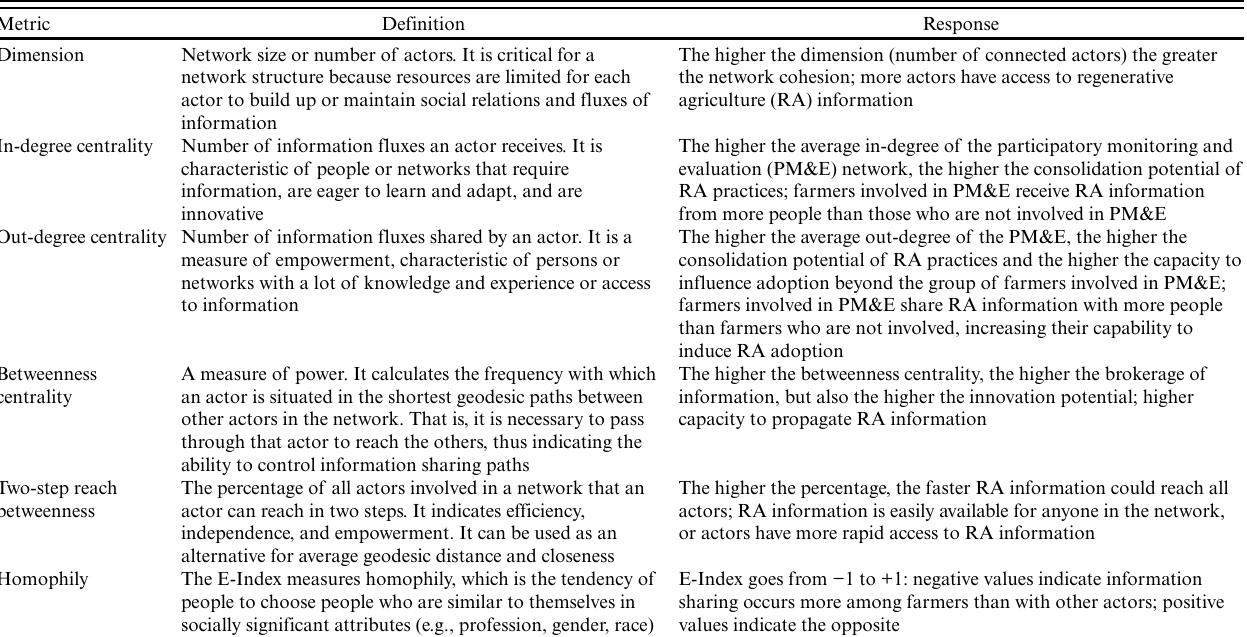
Table 2. Definition of social network analysis metrics regarding information sharing and interpretation of responses to stimulate social learning about regenerative agriculture and enhance its adoption and